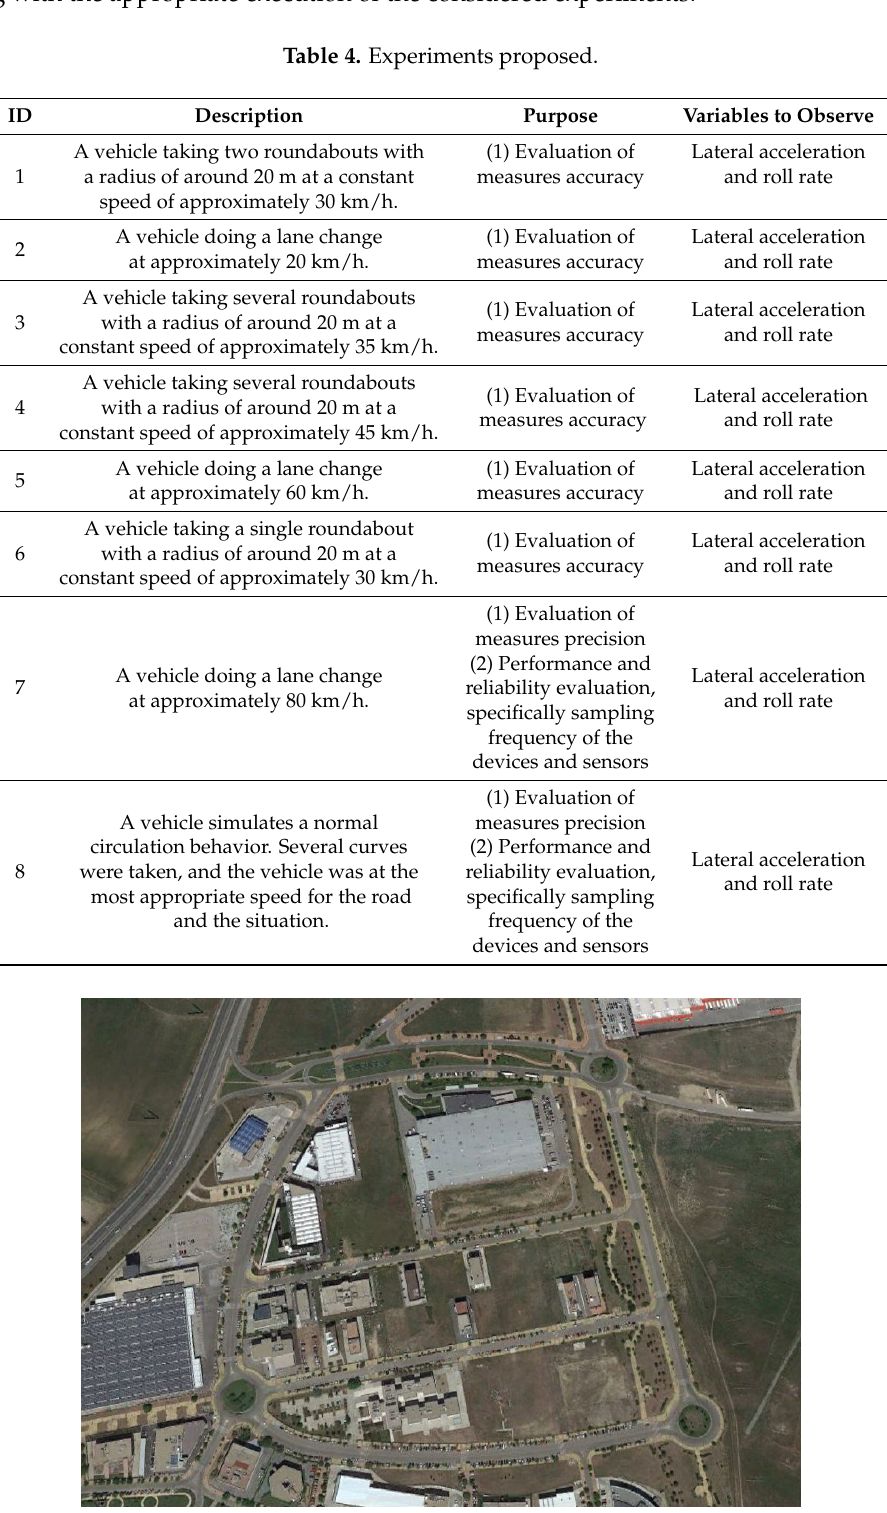
Figure 4. Experiments’ context (Map scale 1:7800